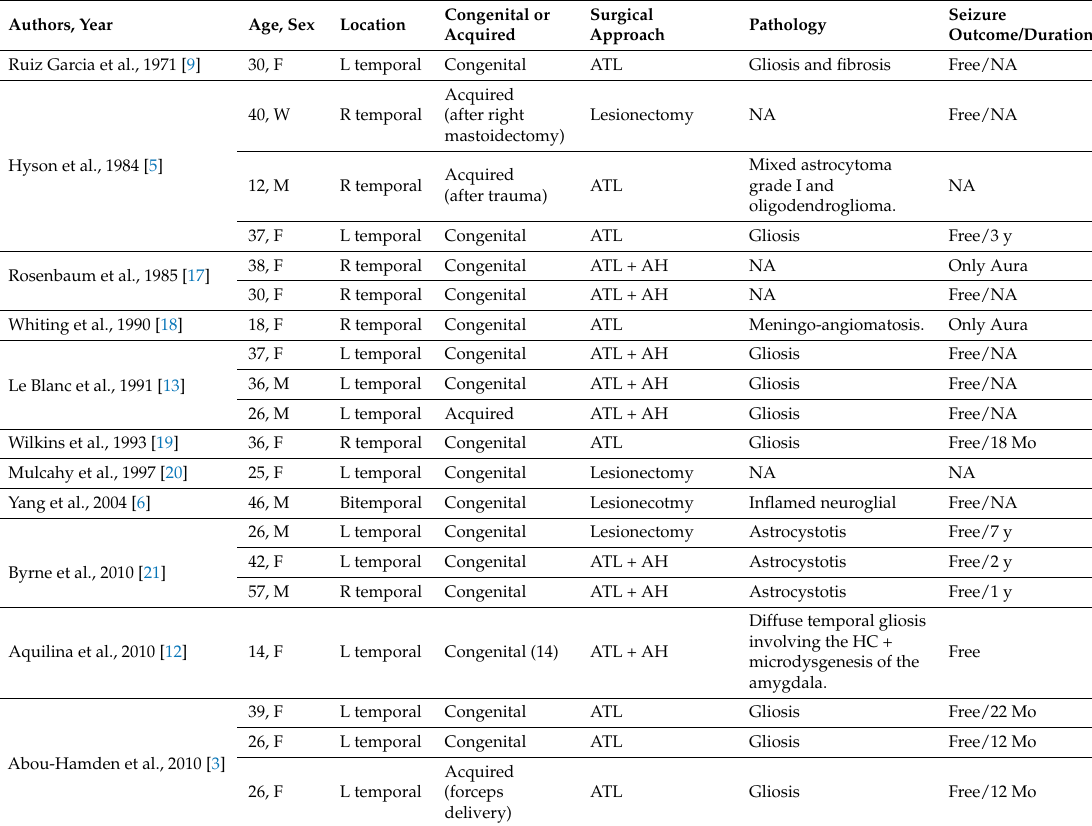
Table 1. Reported surgically treated temporal lobe encephaloceles in patients with